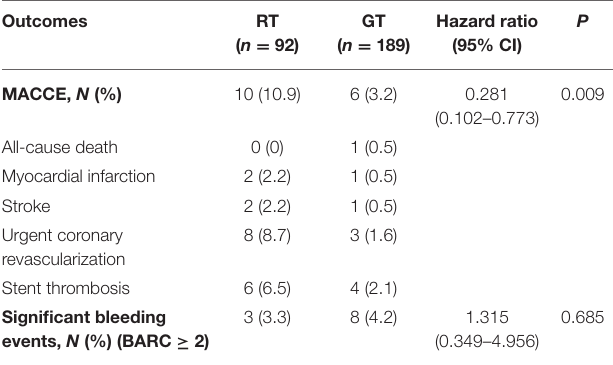
TABLE 3 | Primary and safety endpoints during 12-month